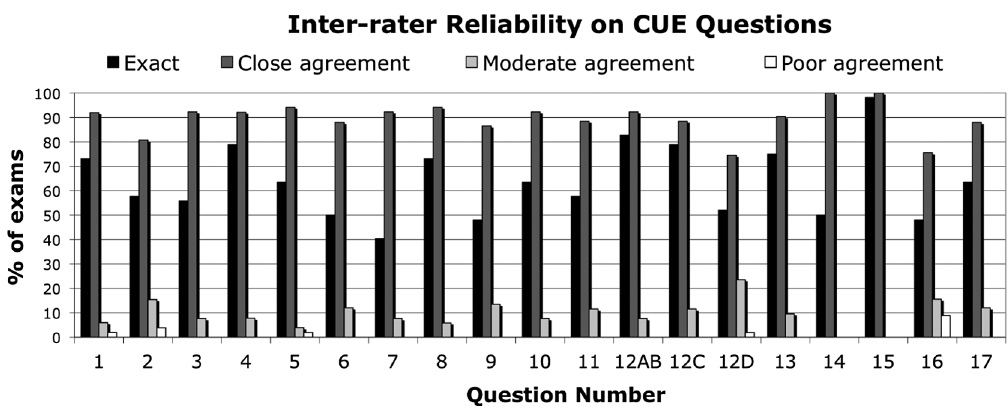
FIG. 4. Inter-rater differences on CUE questions for 52 exams. ‘‘Close agreement’’ is agreement within (cid:5) 20% ( (cid:5) 1 point on a 5 point question), ‘‘moderate’’ is within (cid:5) 20% – 50% ( (cid:5) 1 – 2 : 5 points on a 5 point question), and ‘‘poor’’ is off by 50%–100%. Blanks omitted (thus, exam N varies slightly per question, with a maximum of 52 exams per